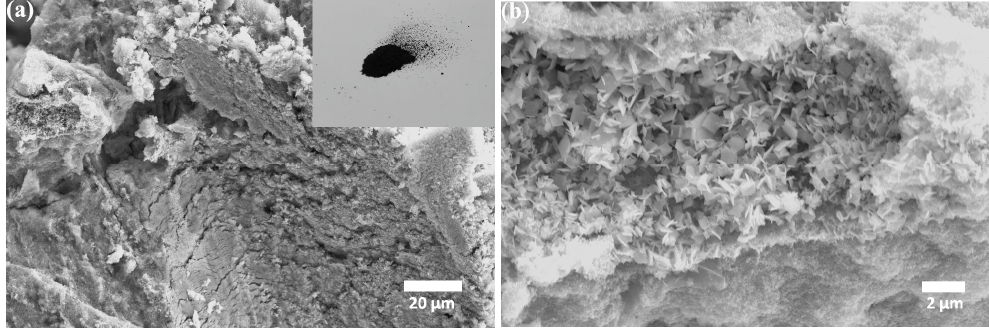
Figure 2. SEM patterns of vacant BiCuSO at various magnifications. Inset: A digital photograph of vacant BiCuSO powders.